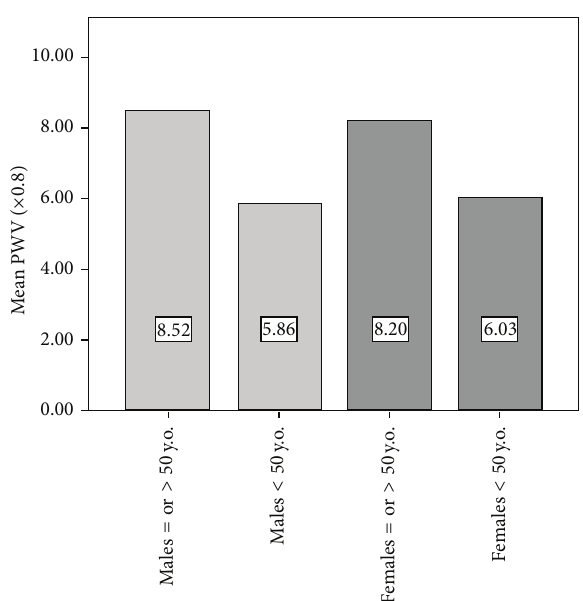
Figure 3: Mean values of pulse wave velocity (PWV: in meters per second) showing significant differences between young subjects ( ≤ 50 years) and subjects > 50 years included in the study. There were no significant differences of PWV in relation to gender for the same age